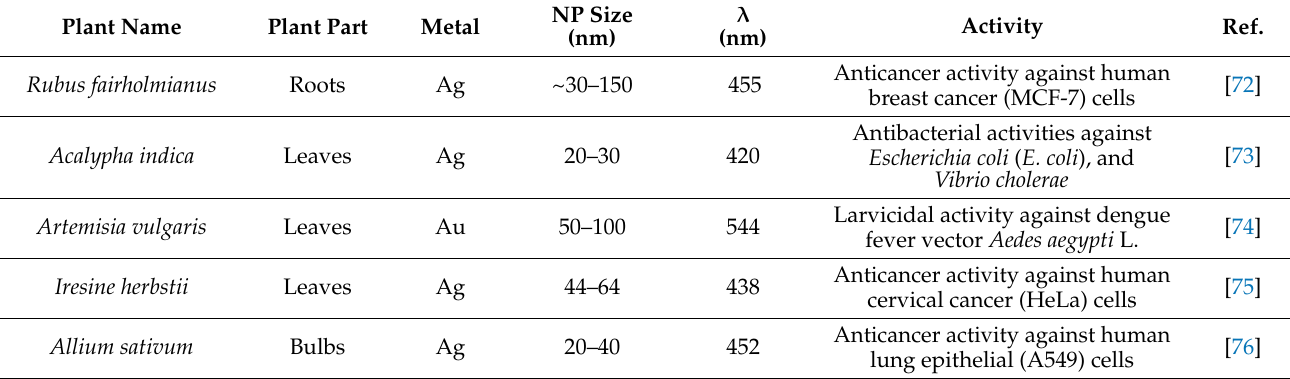
Table 4. Common medicinal plants used in the synthesis of metallic NPs for therapeutic